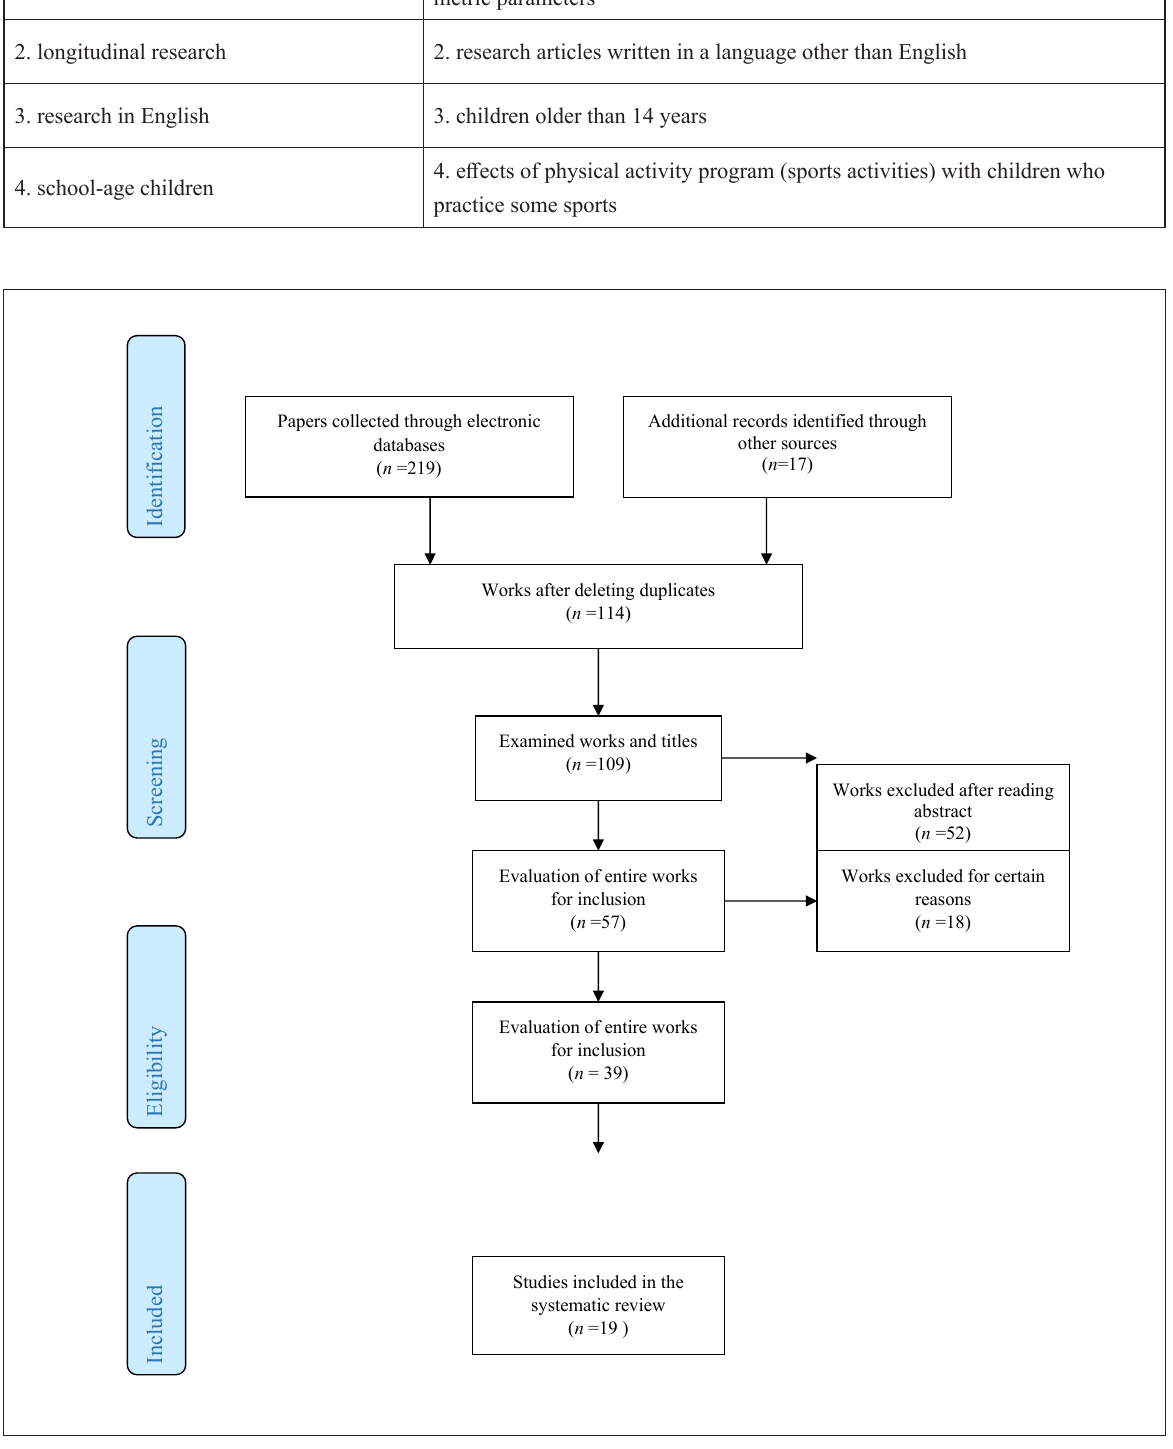
Figure 1. Schematic procedure for the collection, analysis and elimination of works ( Moher, Liberati, Tetzlaff, Altman, & The PRISMA Group,